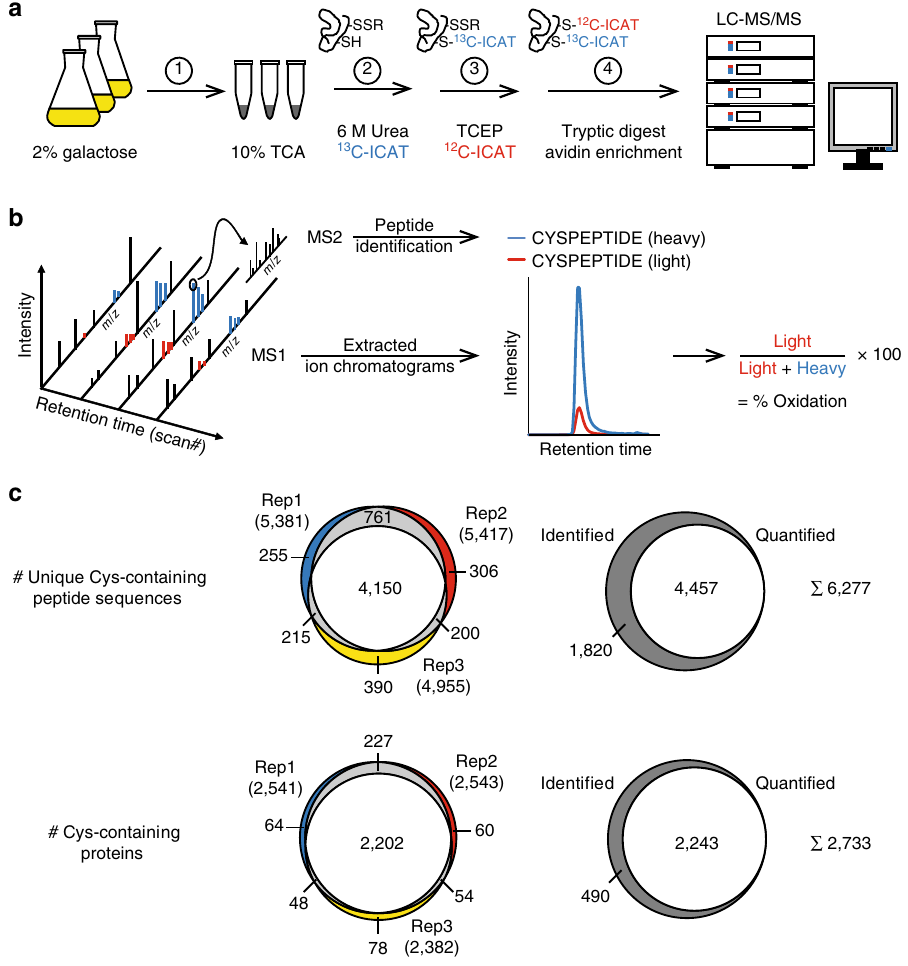
Fig. 1 Site-resolved, large-scale analysis of the in vivo oxidation status of the yeast proteome. a Yeast cells grown in 2% galactose medium were immediately frozen in 10% TCA (1). Extracted proteins were denatured in 6 M urea in the presence of heavy ICAT ( 13 C-ICAT) to label free thiol groups (2). Reversibly oxidised cysteine residues were reduced by TCEP and labelled by light ICAT ( 12 C-ICAT) (3). Proteins were digested with trypsin and ICAT- labelled peptides were enriched by streptavidin af fi nity chromatography (4). Following cleavage of the biotin tag, peptides were analysed in duplicate by LC-MS/MS. b For the determination of the in vivo oxidation status of cysteine residues, peptides were identi fi ed based on fragment ions observed in MS2 spectra using MaxQuant (v.1.4.1.2) and then quanti fi ed by extracting MS1 ion chromatograms using Skyline (v.2.5.0). Following the integration of peak areas of heavy and light peptide variants, the proportion of reversibly oxidised cysteine residues (% oxidation) was calculated. c Overlap of unique cysteine-containing peptides (top) and proteins (bottom) identi fi ed in three biological replicates and the proportion of peptides/proteins quanti fi ed in least two of the three biological